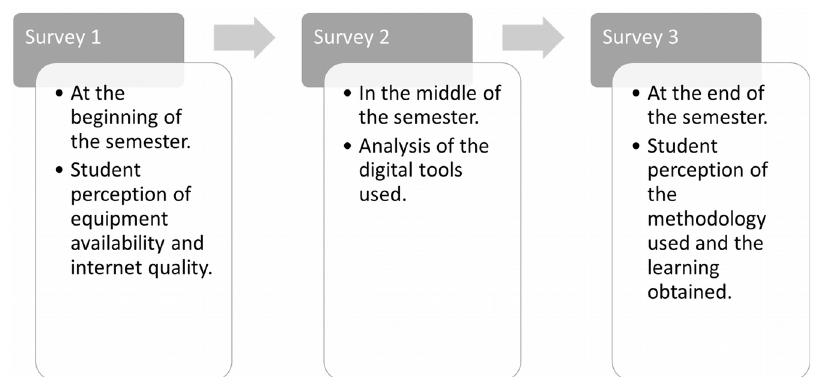
Figure 3. Description of the surveys applied in the